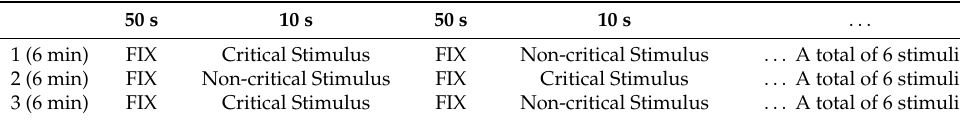
Table 3. Scanning